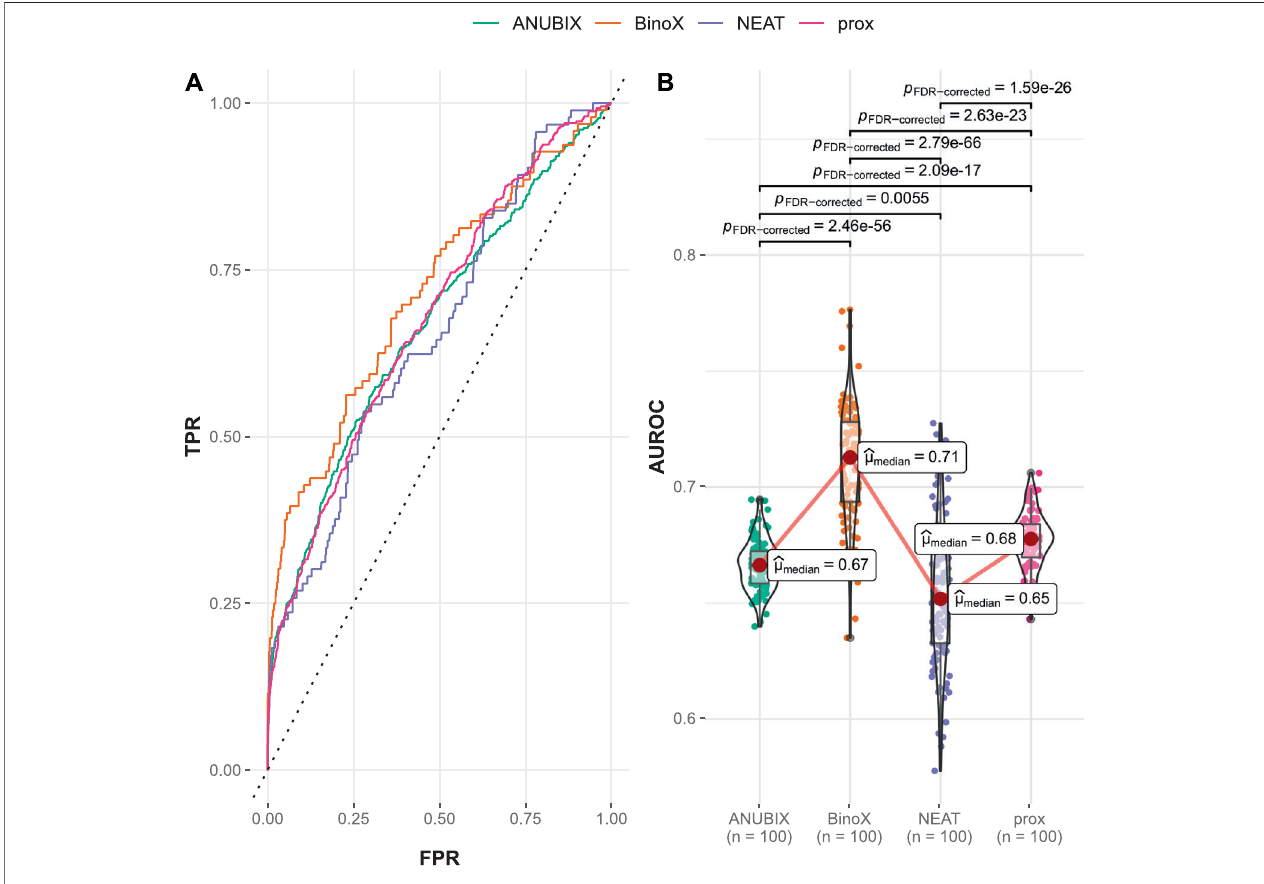
FIGURE 3 | Drug – disease association – based performance on the Guney2016 benchmark. Performance of the different drug repurposing tools: ANUBIX (green), BinoX (orange), NEAT (purple), and proximity (prox, pink) on (A) ROC curves, where the dotted line represents random prediction, and (B) AUROC using sampled sets from the benchmark containing equal numbers of positive and negative drug – disease combinations. The pairwise Wilcoxon rank sum test was used to assess the signi fi cance of difference on AUROC. FDR-corrected p -values were obtained using the Benjamini – Hochberg procedure.